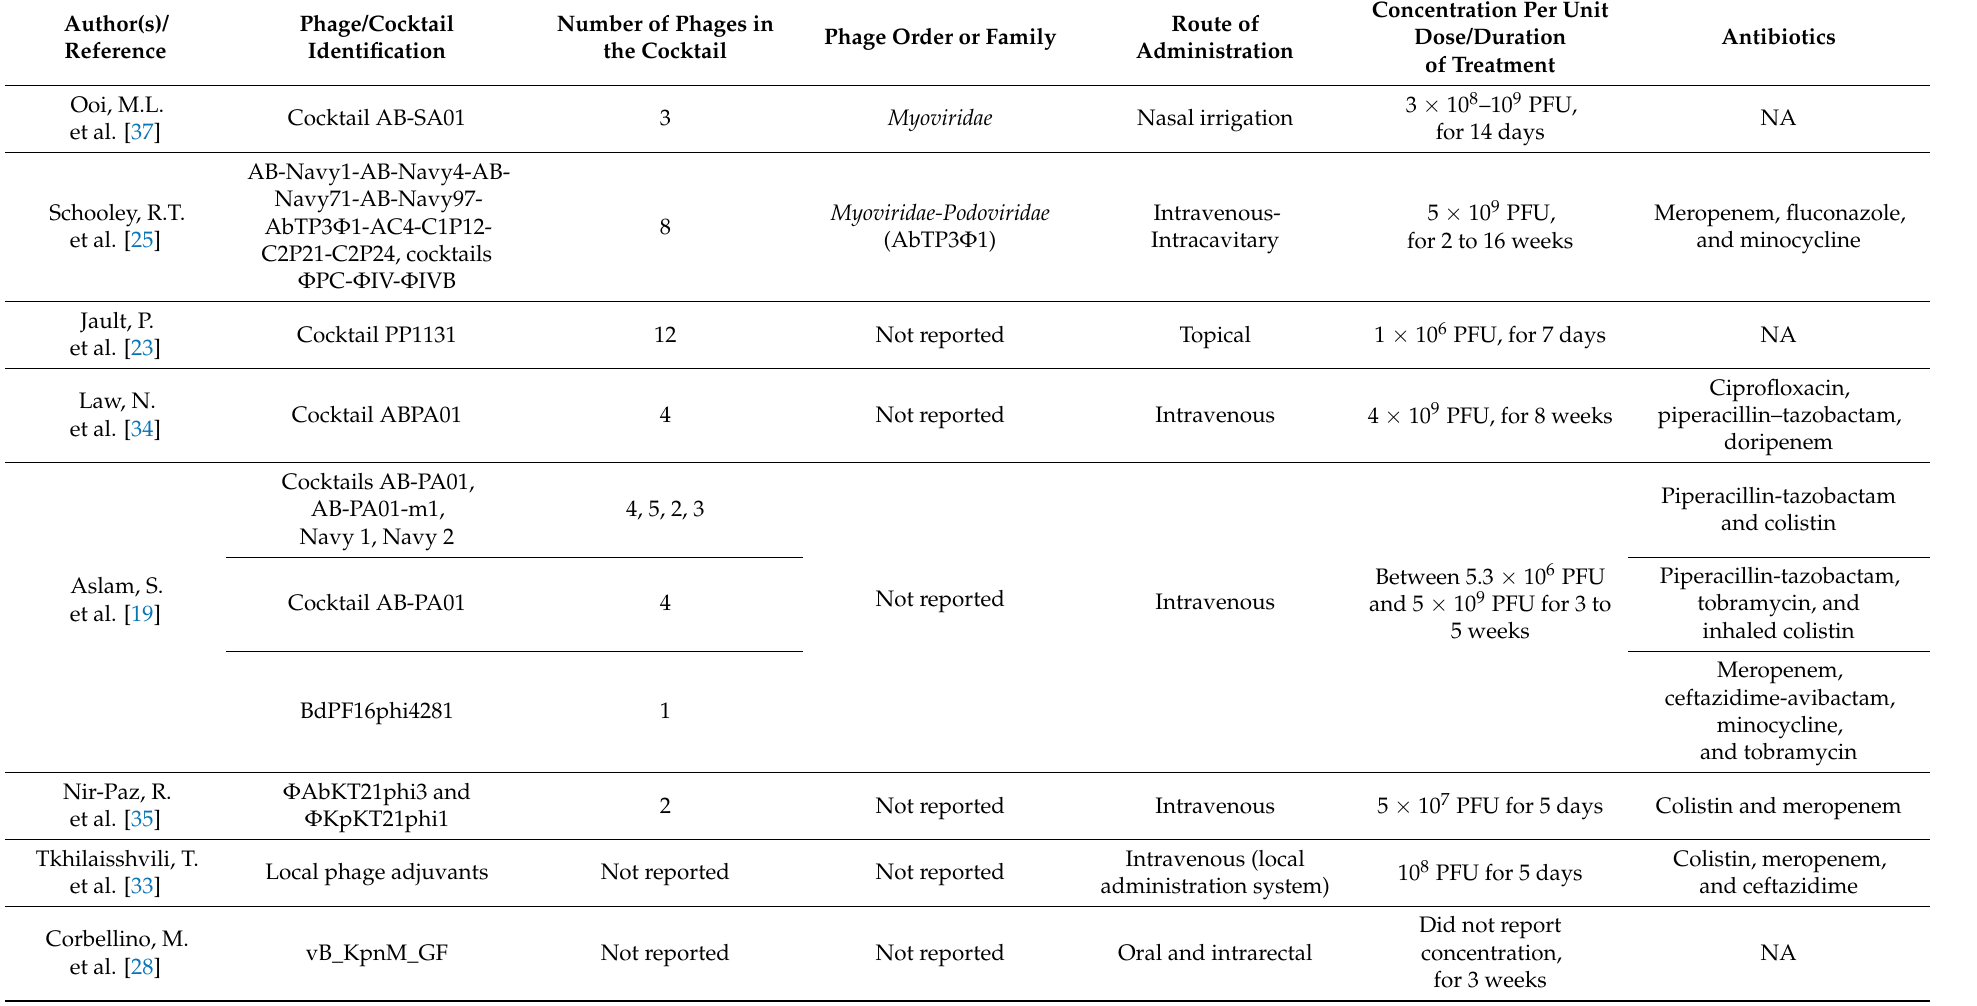
Table 2. Characteristics of the bacteriophages used for the treatment of